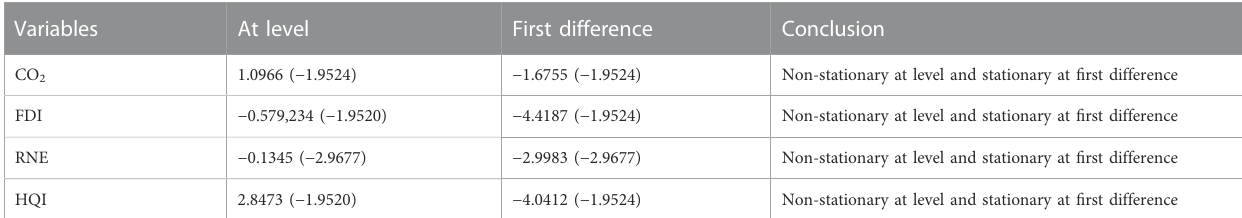
TABLE 1 Unit Root